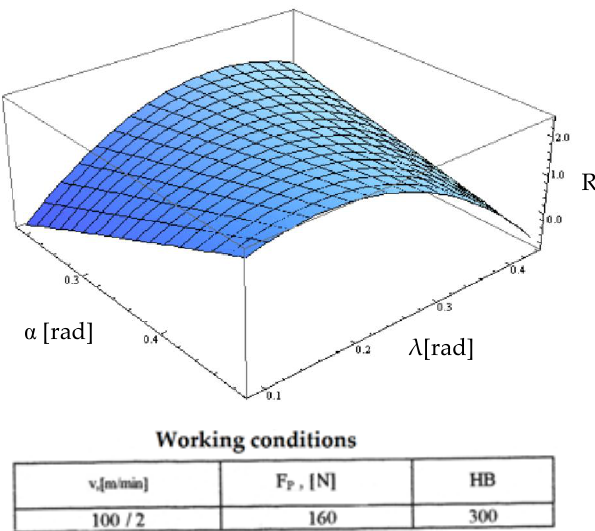
Figure 22. Influence of the clearance angle and inclination angle on roughness R a .